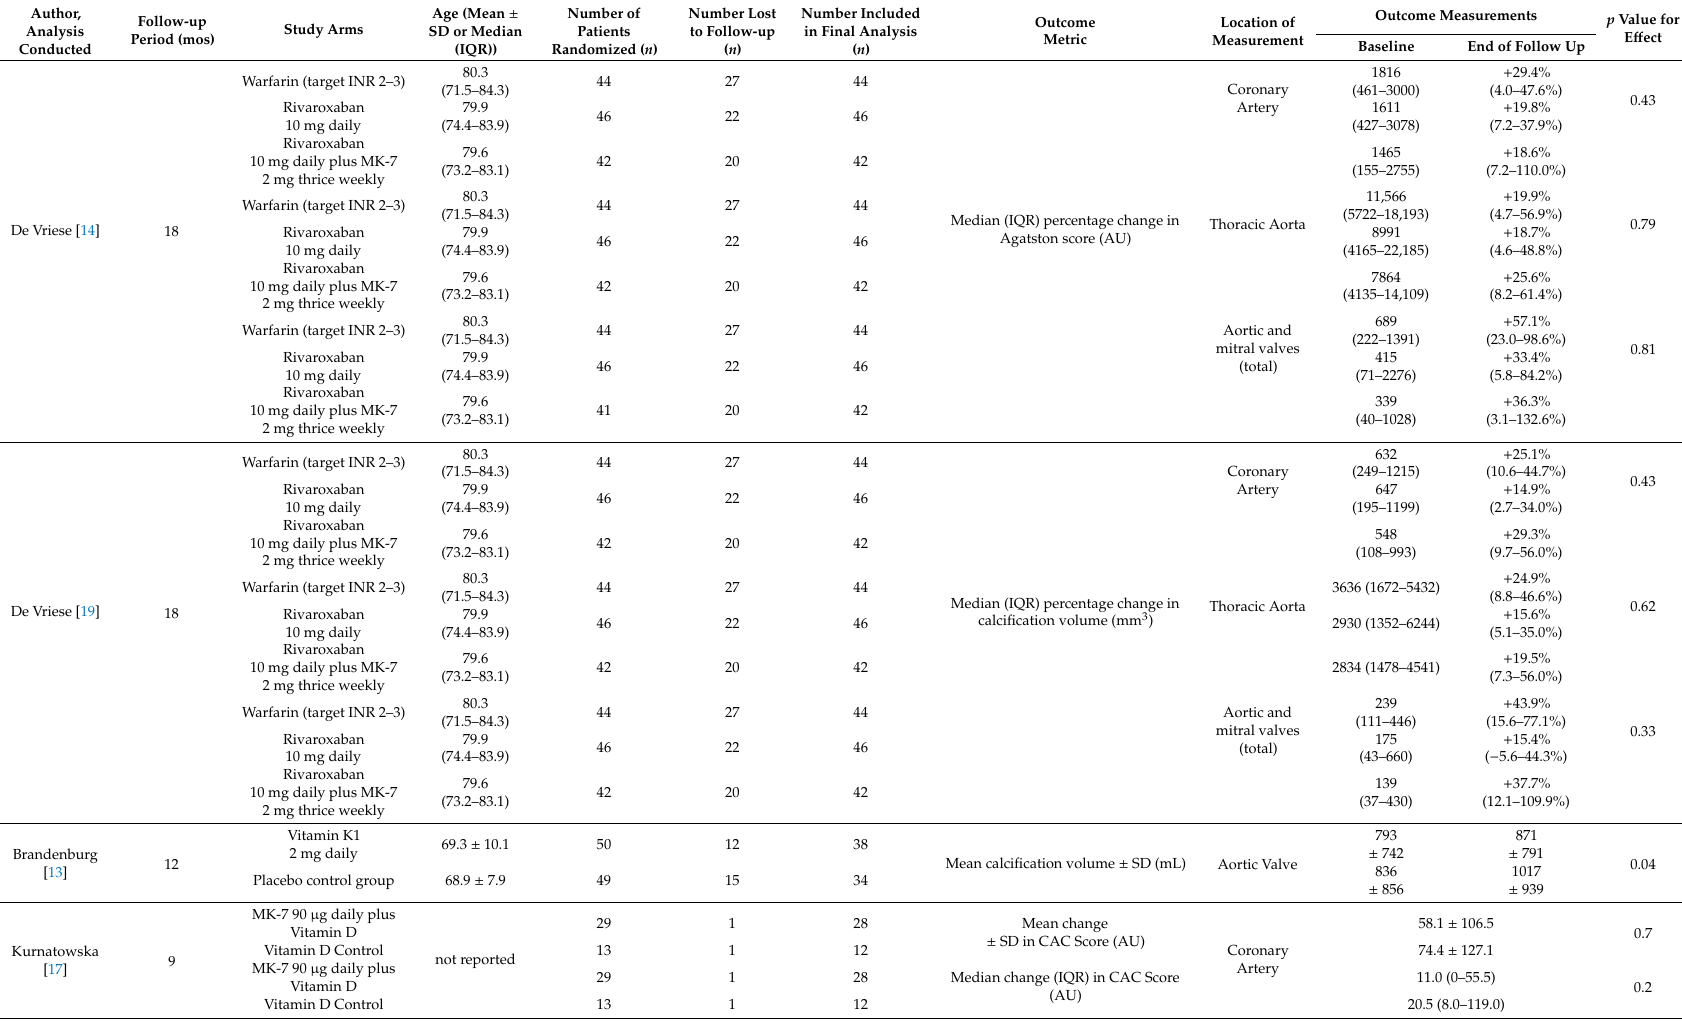
Table 4. E ff ect of vitamin K supplementation on calcification